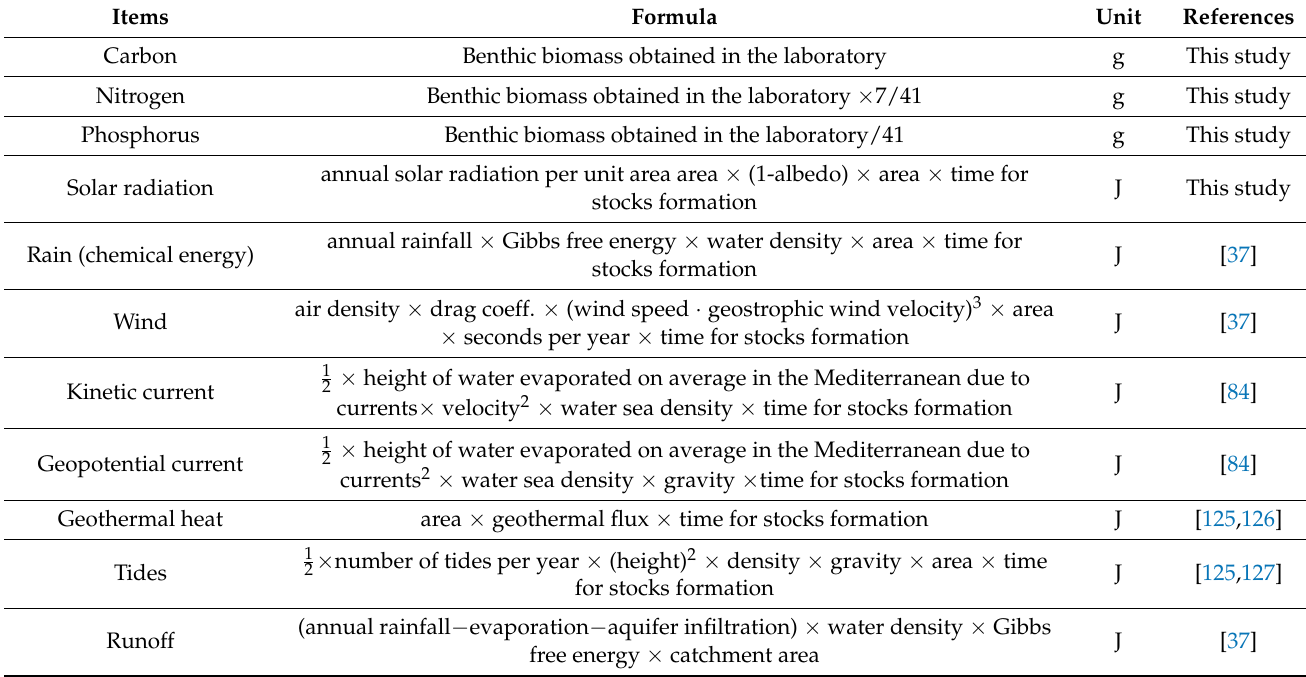
Table A2. Formulas used to calculate all the resources invested to support primary production within the biocenosis.